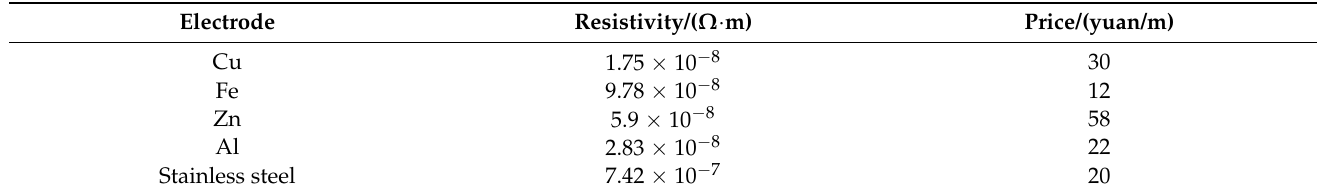
Table 7. Performance indicators of metal electrode materials.